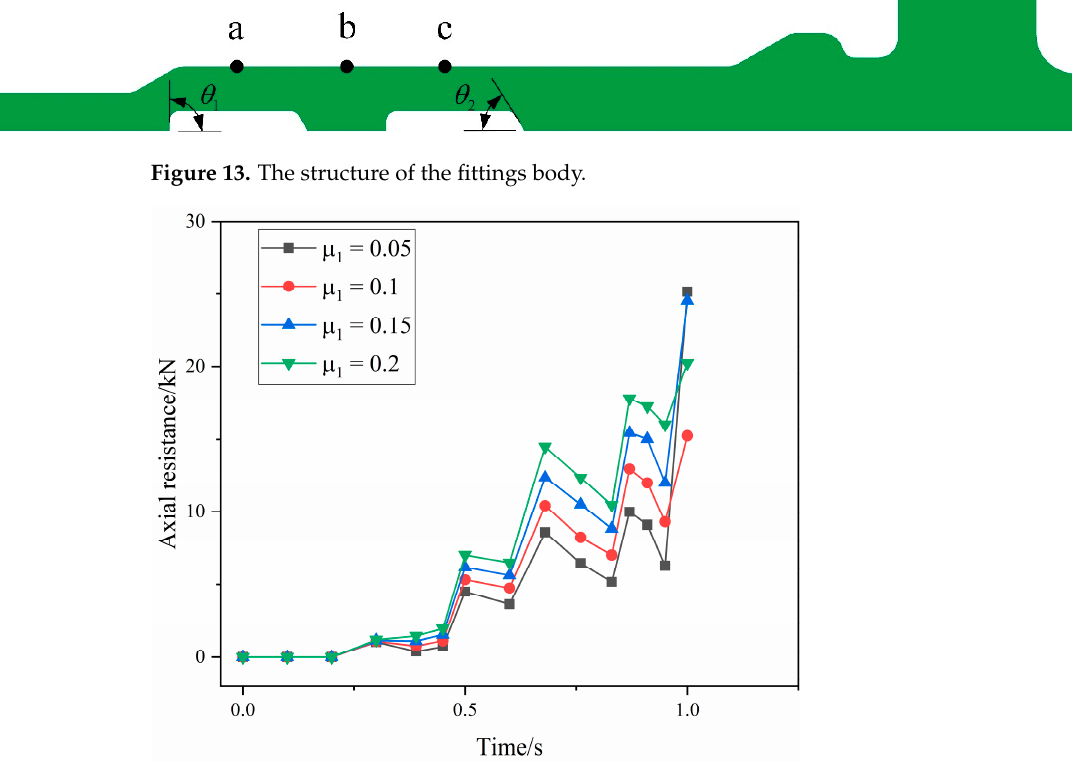
Figure 14. The variation of axial resistance between the extrusion ring and fittings body under different friction coefficients.